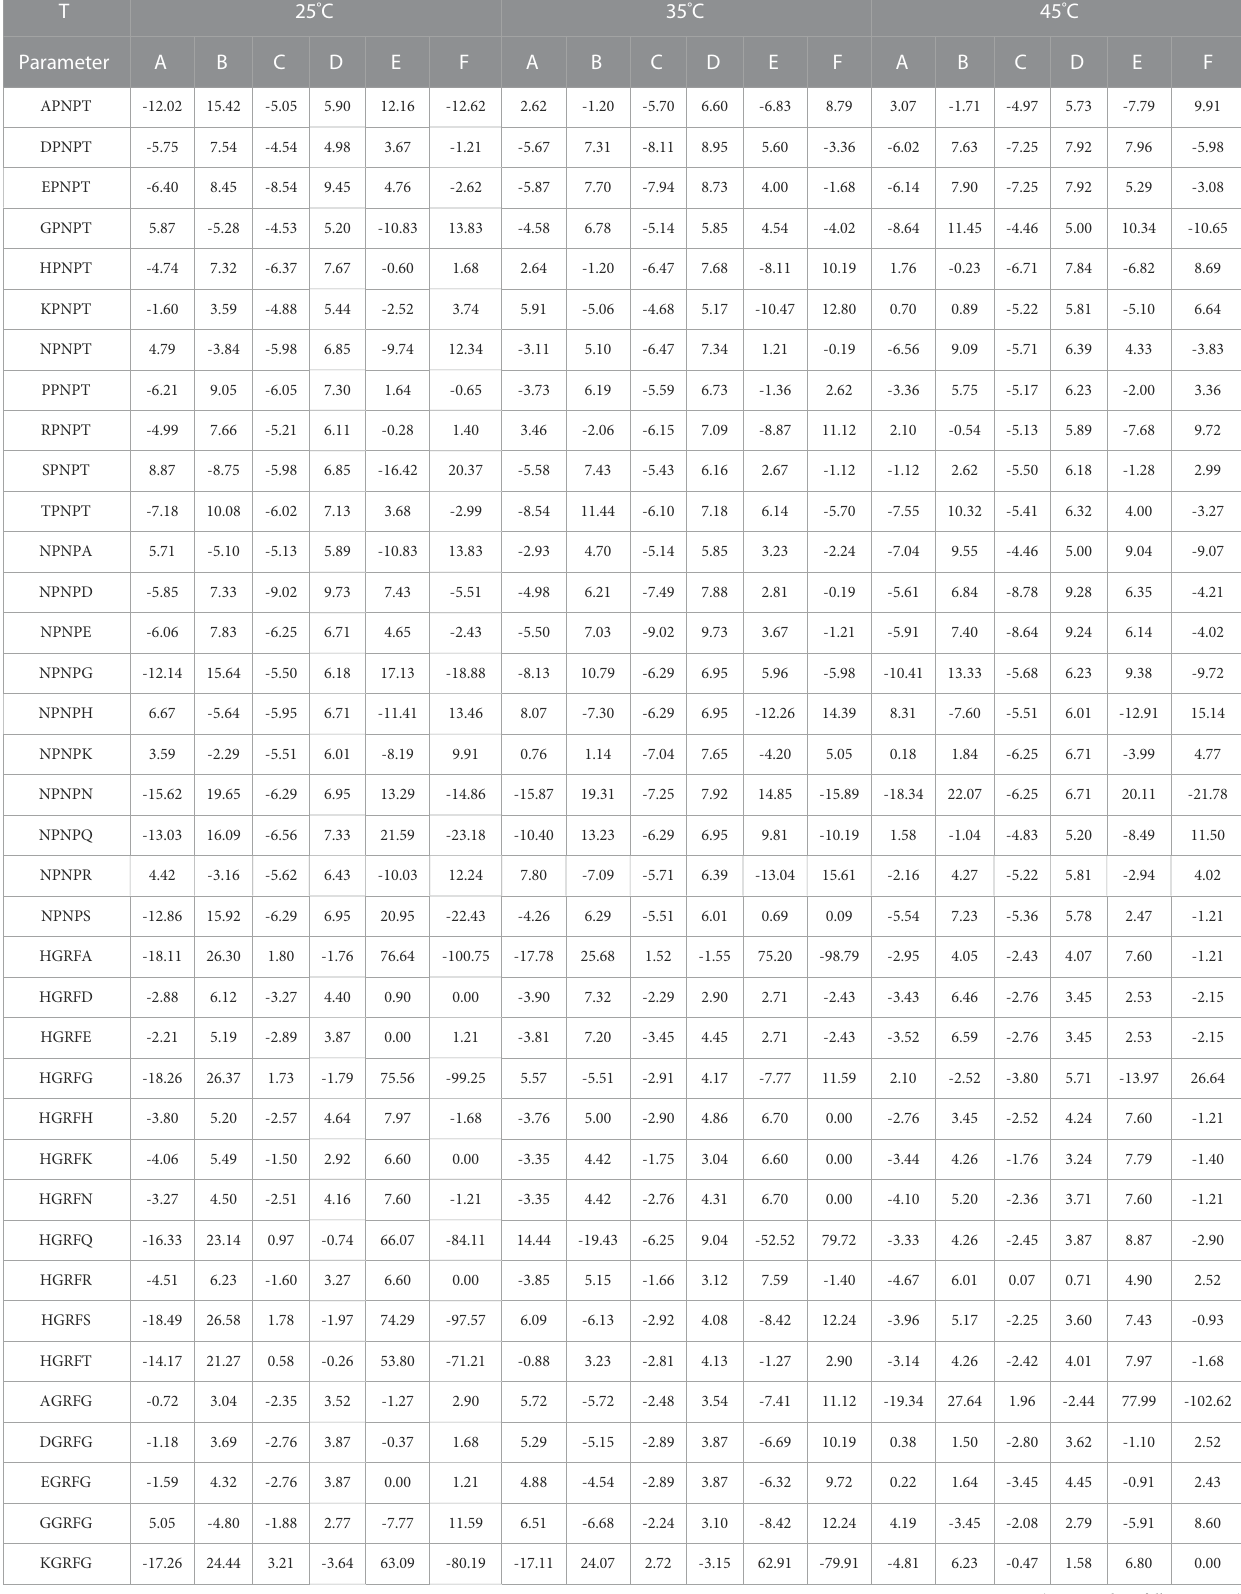
TABLE 7 Parameter results of fi tting with P N m and pH at different temperatures. T 25 ° C 35 °